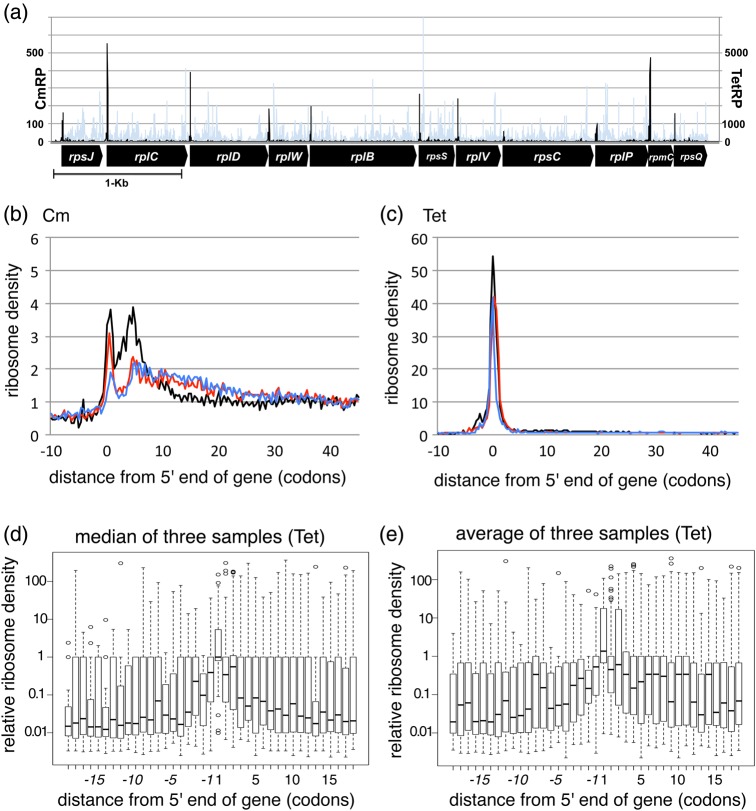
Difference in TetRP and CmRP signal patterns. (a) TetRP and CmRP patterns of a ribosomal protein operon. TetRP (Black) and CmRP (light gray) patterns over an operon coding ribosomal proteins are shown. Location of each gene is shown by an arrow. (b) CmRP and (c) TetRP patterns near 5′ end of coding region of genes. Genes longer than 500-bp were selected, and read depths from −5 to +495 from the first base of initiation codon were normalized to an average value of the region, then the depth of all genes was averaged. Results from three independent cultures are shown in different colours. (d, e) Relative TetRP signal distribution at in-frame ATG codons near initiation codons of known genes is compared with signals at the corresponding initiation codon. (d) Median and (e) average signals at a position from three samples were used for calculation. Median, upper and lower quartiles of all ATG codons at indicated distances are boxed. This figure is available in black and white in print and in colour at DNA Research online.